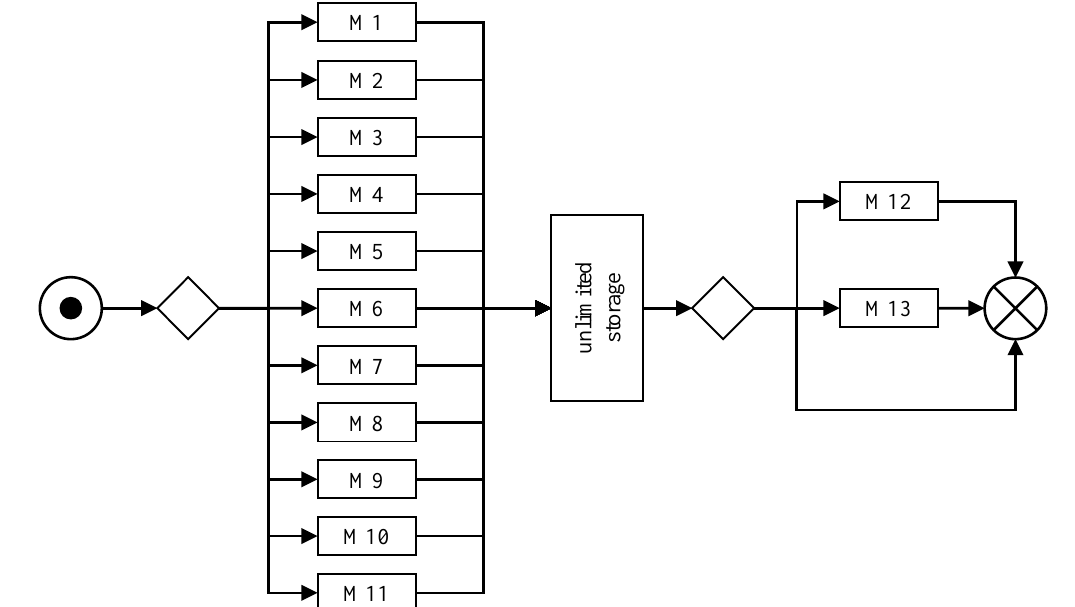
Figure 1. System layout of the hybrid flow shop in the application